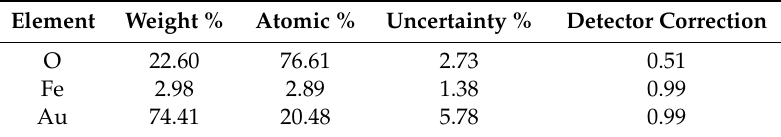
Table 3. Elemental analysis of gold coated synthetic iron oxide nanoparticles.